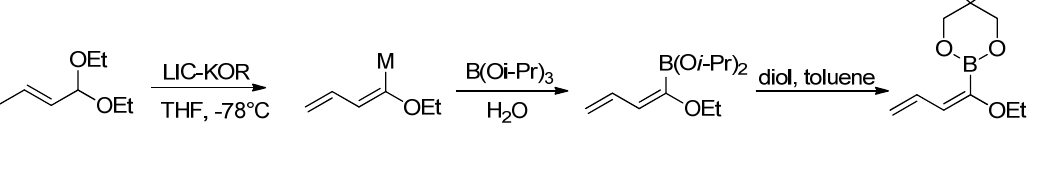
Scheme 19. Synthesis of butadienyl boronic